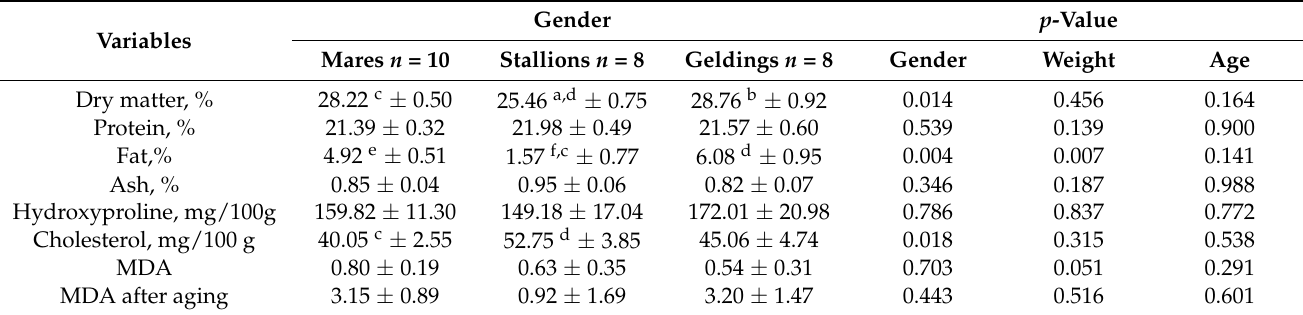
Table 2. Effects of horse gender, age, and carcass weight on proximate composition of m . pectoralis profundus muscle.